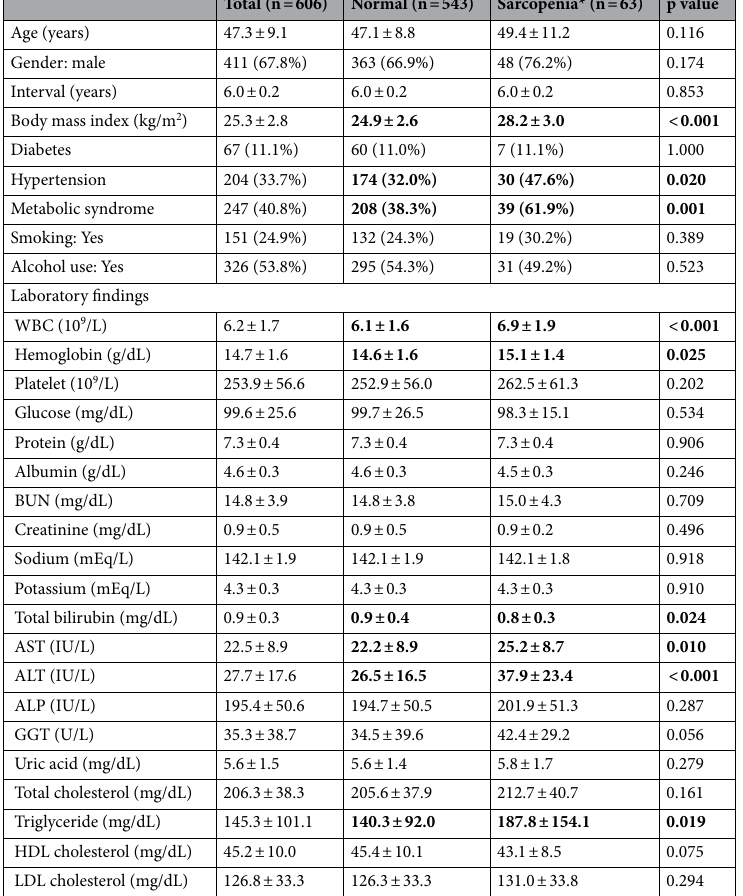
Table 1. Baseline characteristics by initial sarcopenia status (bold: p value < 0.05). WBC White blood cell, BUN Blood urea nitrogen, AST Aspartate aminotransferase, ALT Alanine aminotransferase, ALP